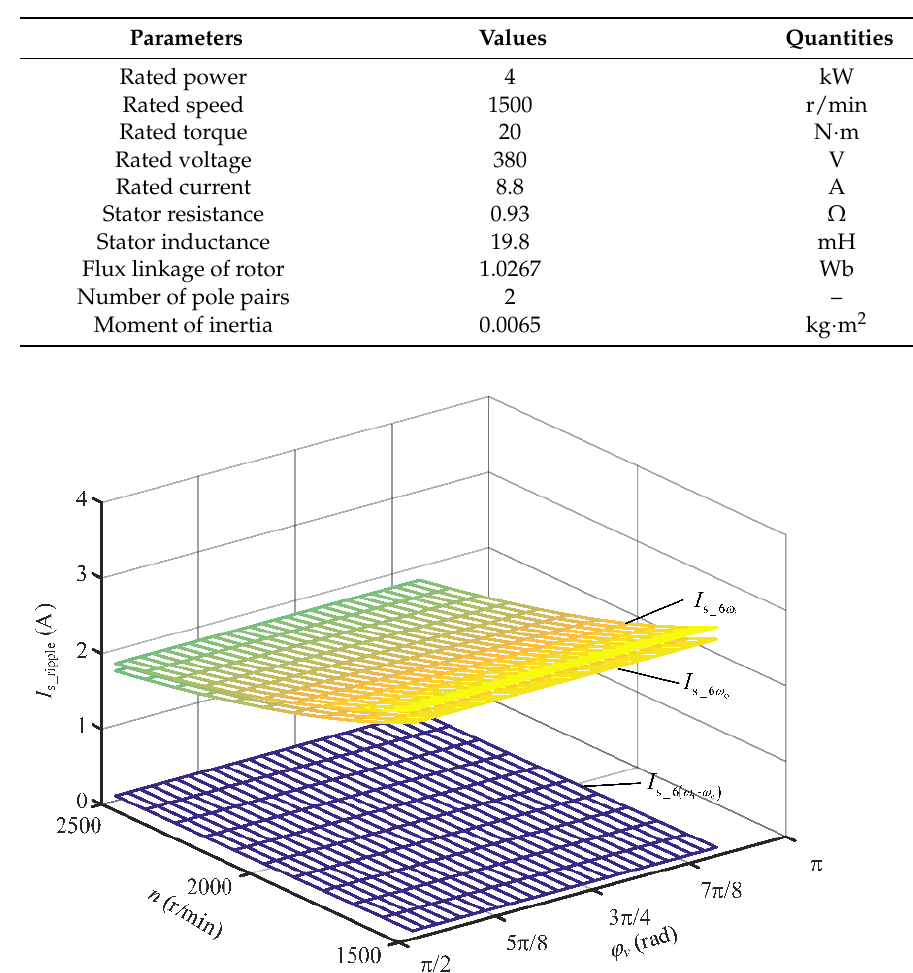
Figure 8. Stator current harmonics at different low-order frequencies.